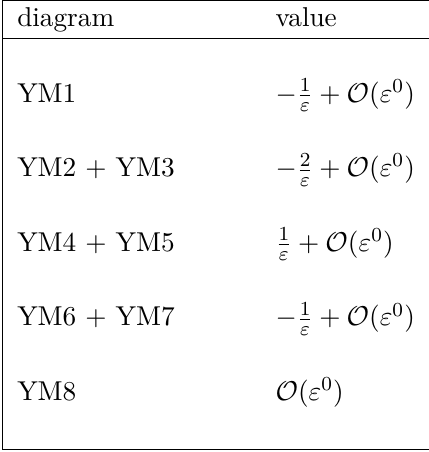
Table 3. UV divergences of the diagrams from figure 10 in units of C 2 ( R ) g